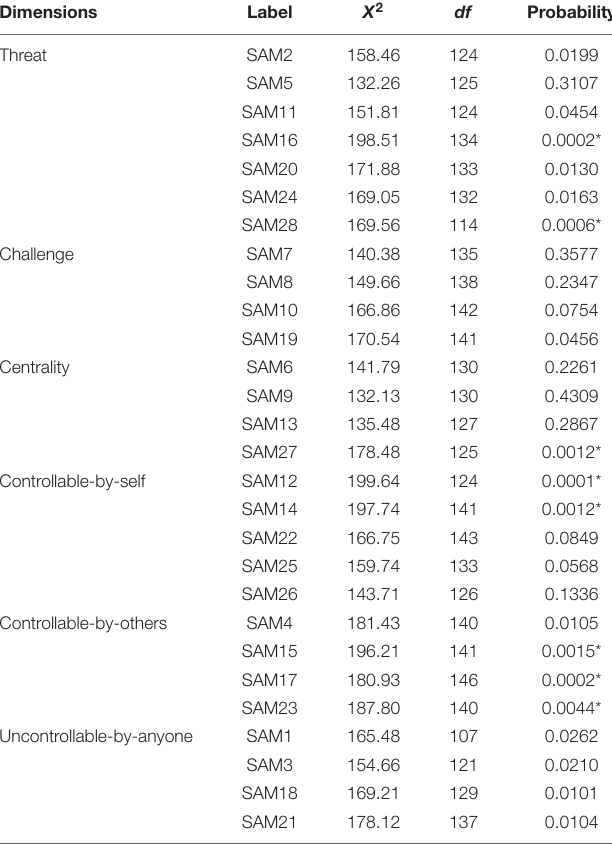
TABLE 3 | S- X 2 item level diagnostic